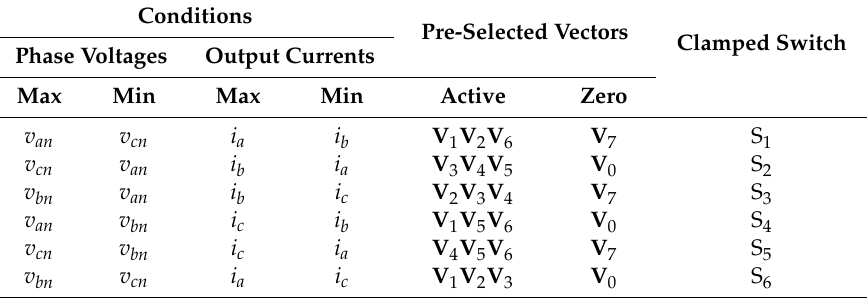
Table 1. Conditions of the vector